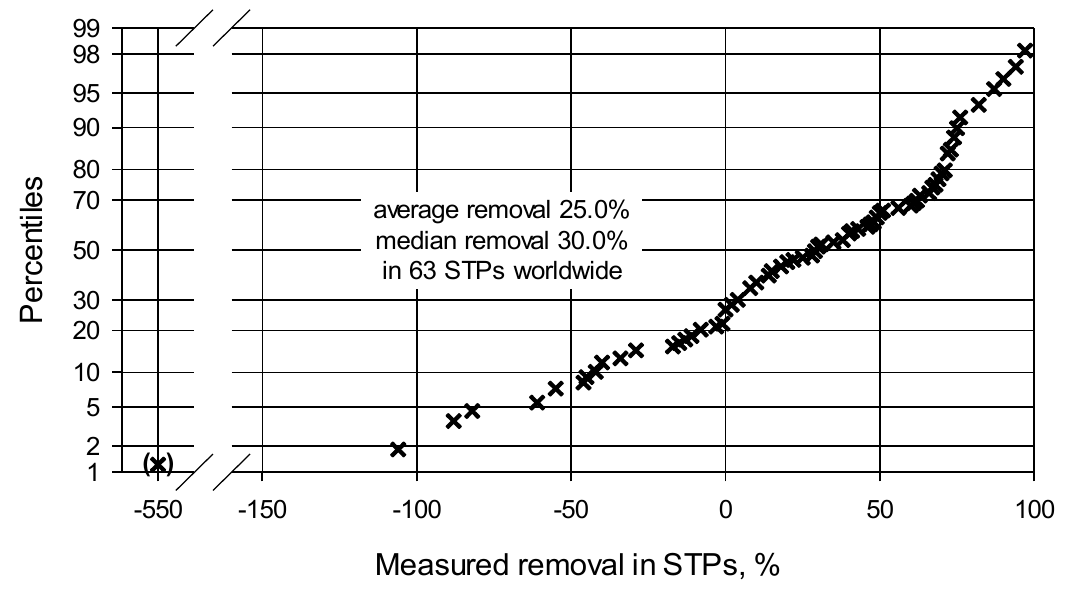
Figure 1. Distribution of 107 published degradation/removal rates of Trimethoprim (TMP) in 63 sewage treatment plants (STPs)